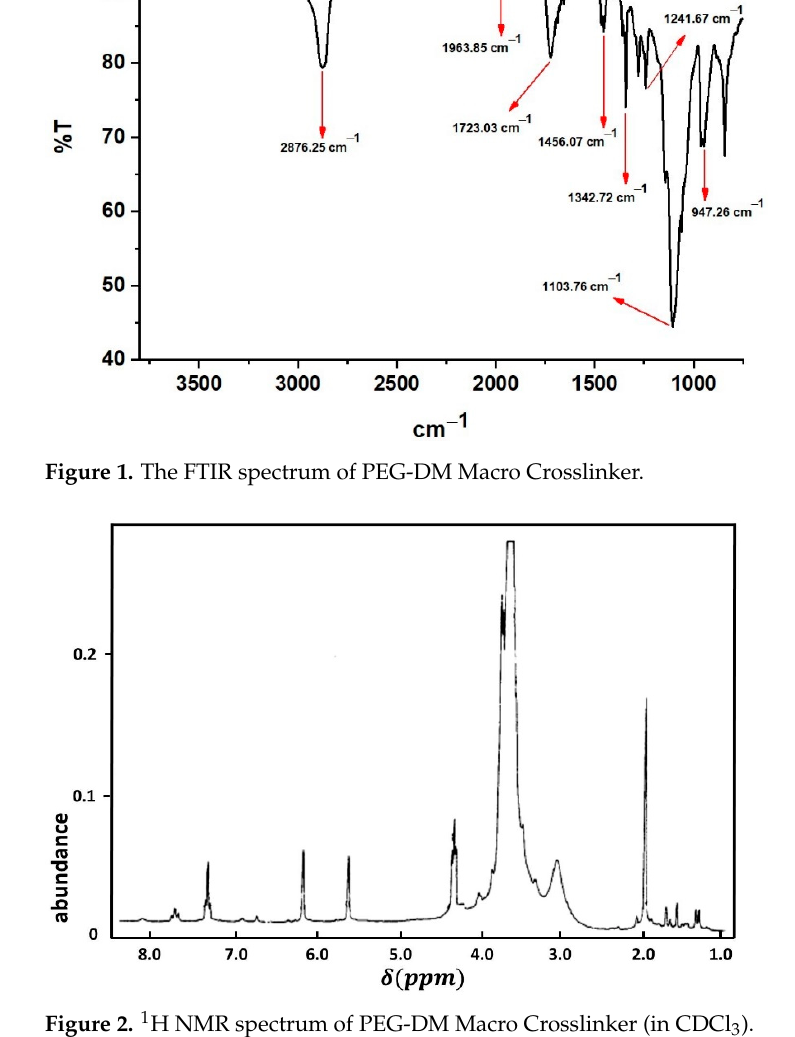
Figure 2. 1 H NMR spectrum of PEG-DM Macro Crosslinker (in CDCl 3 ). The IR (cm − 1 ); 1723.03 (C=O), 1560.04 (C=C), 1103.76 (C–O–C). NMR ( δ , ppm); 2.0 (CH 3 ), 3.5 (–CH 2 –O–CH 2 ), 5.6–6.2 (vinylic